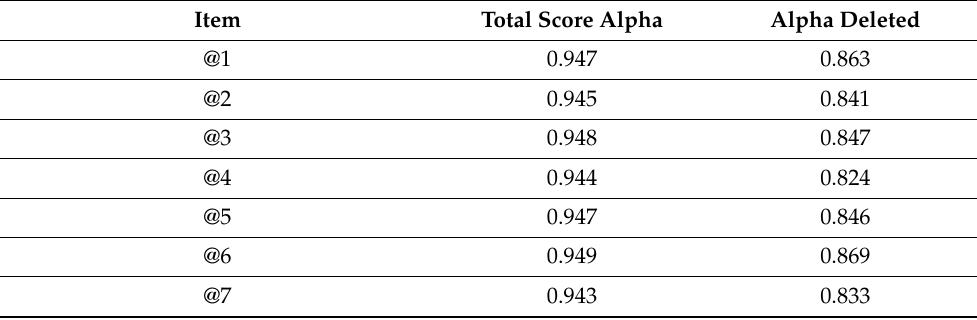
Table 2. Comparing the total score Cronbach’s alphas of the items and